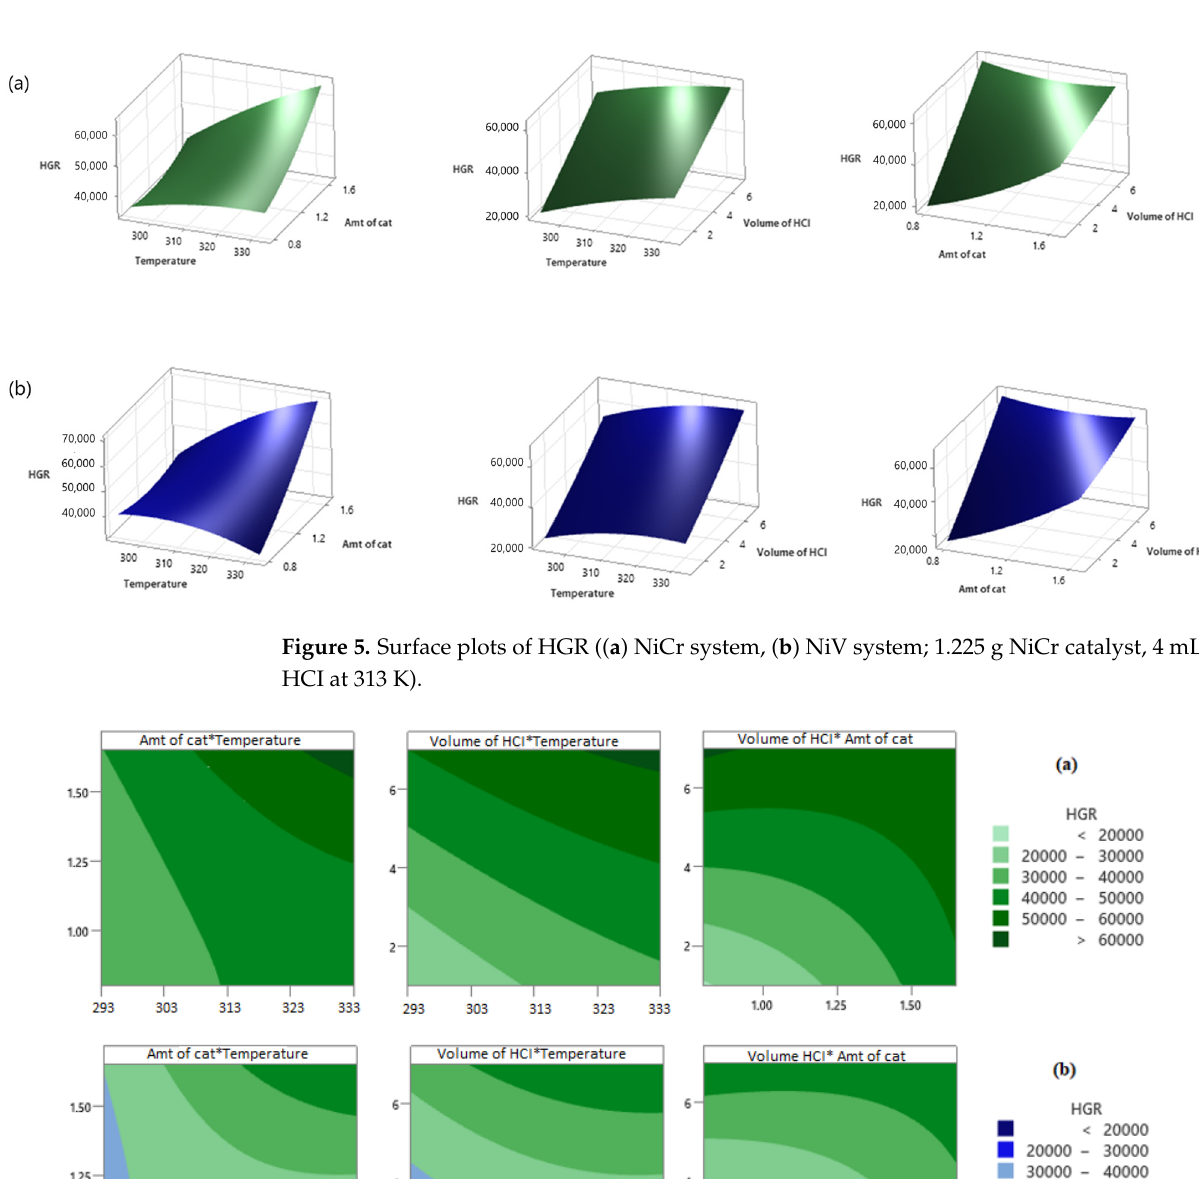
Figure 7. Graph of generated hydrogen volume versus time (1.65 g of catalyst, 6% KBH 4 , 3% NaOH, and 7 mL of 0.5 M HCl at 333 K).